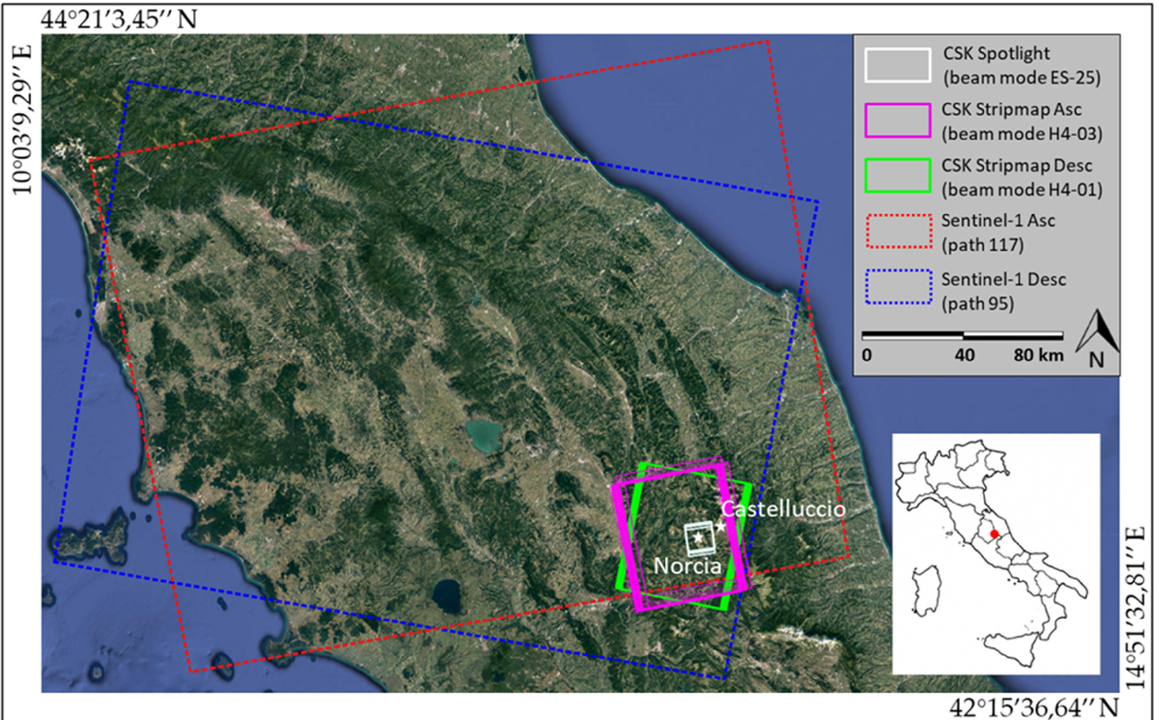
Figure 2. Footprints of the selected SAR datasets over Norcia and Castelluccio towns.